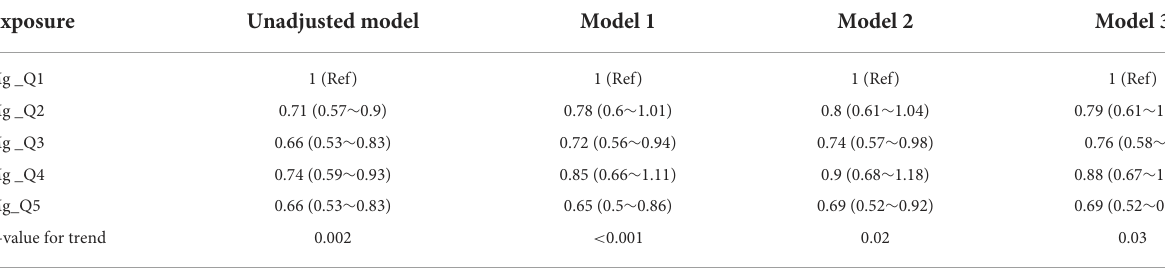
Model1:adjustedforgender,age,race. Model2:Model1 + adjustedforsmoke,PIR,alcohol. Model3:Model2 + smoke,alcoholandBMI,DM.